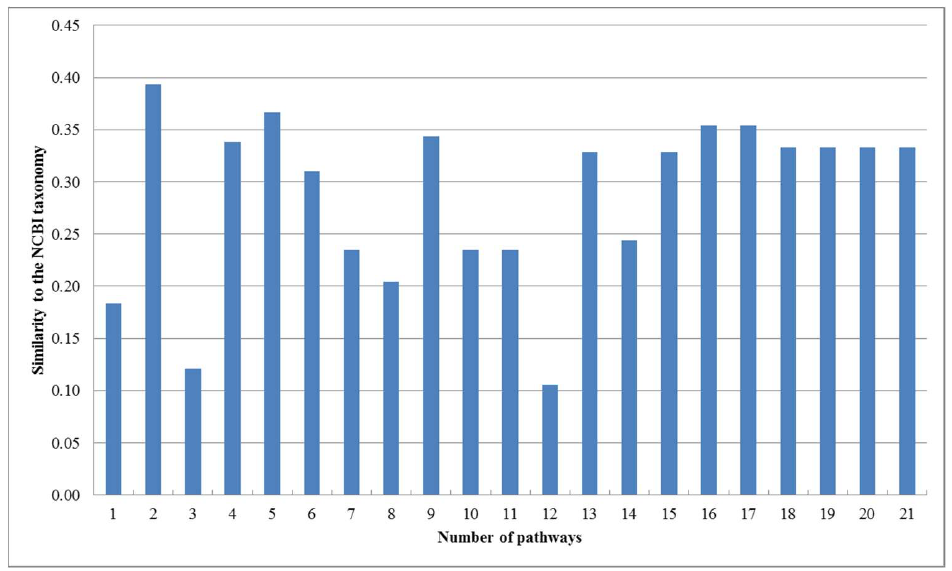
Figure 3. Similarities between our trees and the NCBI taxonomy for the 16 organisms.